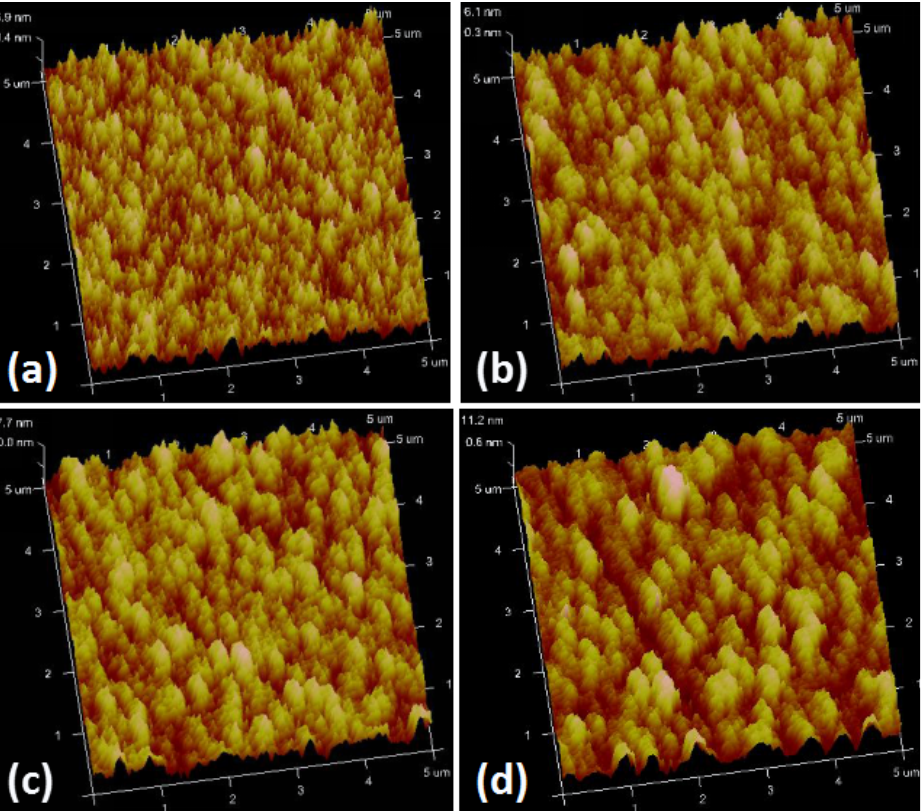
Figure 2. 3D morphology of the AFM images (5×5 um2) of the InN nanodots grown at different sputtering powers: (a) 80W, (b) 90W, (c) 100W and (d) 110 W.